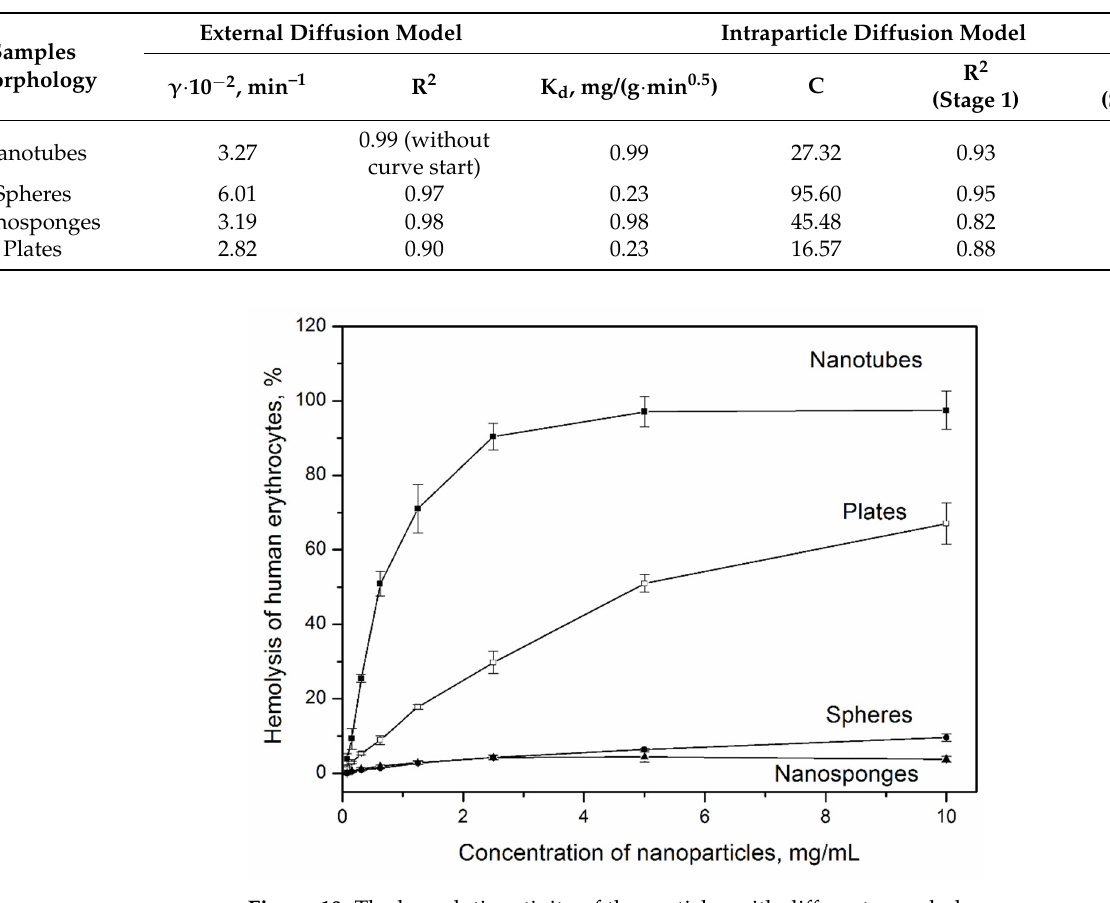
Figure 11. The effect of samples morphology on cell viability according to MTT test results. The results of the MTT test show that the nanotubular sample exhibits pronounced cytotoxicity. Even at the lowest sample concentration of 0.08 mg/mL, cell survival is 80%. As the sample concentration increases, the survival rate of samples sharply decreases and tends to zero at concentrations from 2.5 to 10 mg/mL Samples with other particles